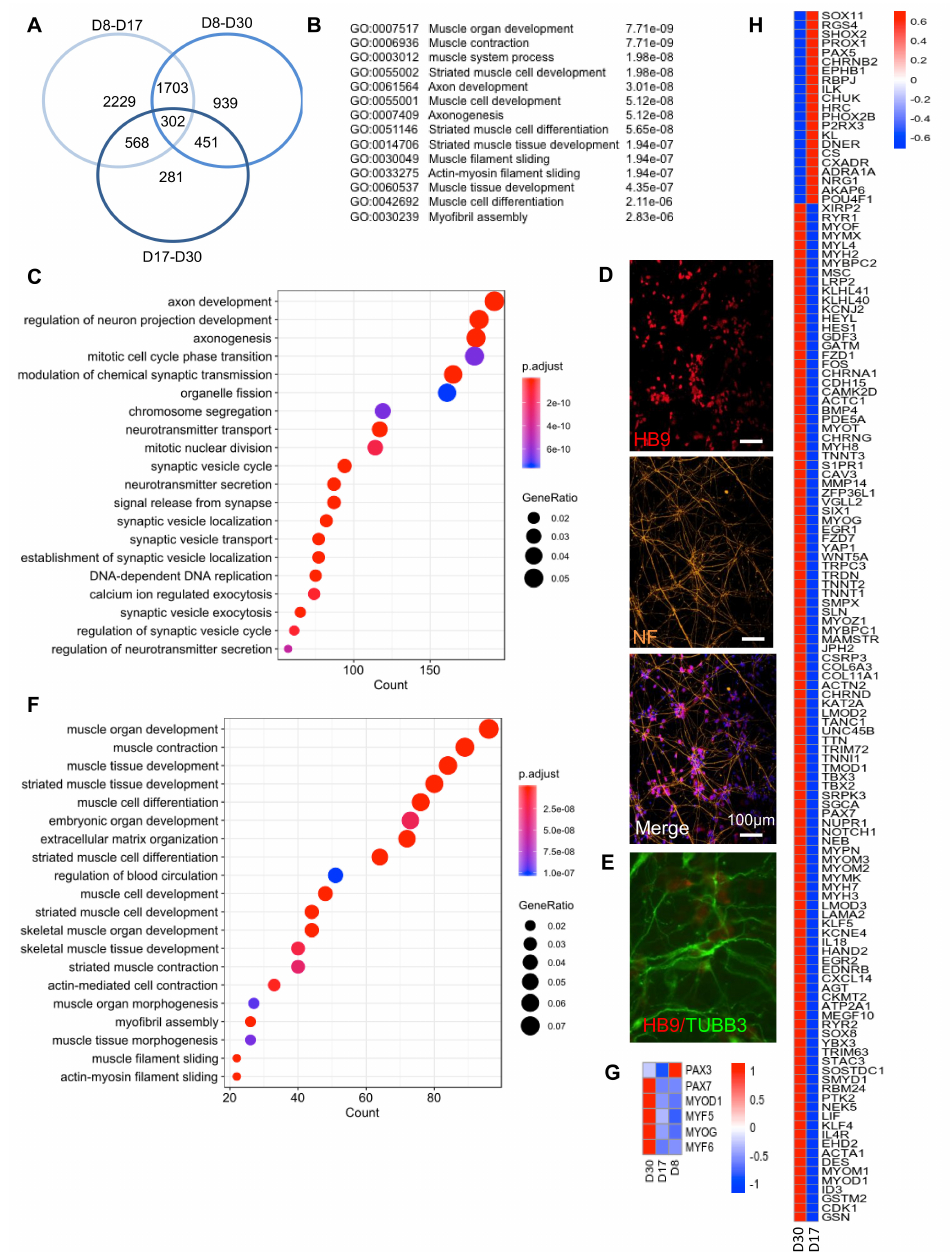
Figure 3. Transcriptomic profiling of in vitro di ff erentiated innervated muscle fibers at day 8, 17 and 30 postdi ff erentiation. ( A ) Venn diagram showing the number of genes di ff erentially regulated between D8 and D30, D8 and D17 or D17 and D30. The three time points correspond to the main medium changes. Genes were selected based on a p adj < 0.05. Lists of genes that are di ff erentially expressed between D8–D17, D17–D30 and D8–30 are given in Supplementary Table S1. ( B ) List of the most significant Biological processes (BP) corresponding to the 302 genes common to the three time points with associated GO term and p adj values. ( C ) Biological pathways significantly overrepresented between D8 and D17. ( D ) Representative Z stacks of hiPSC-derived motor neurons using anti HB9 antibodies (upper panel, red), anti-Neurofilament (NF, orange, medium) and merged (bottom) with nuclei counterstained with DAPI. ( E ) Immunostaining of hiPSC-derived motor neurons using anti HB9 antibodies (red) and anti-TUB β 3 (green) with nuclei counterstained with DAPI. ( F ) Biological pathways significantly overrepresented between D17 and D30. ( G ) Heatmap of the di ff erent myogenic transcription factors at D8, D17 and D30. ( H ) Heatmap of di ff erentially expressed genes corresponding to “skeletal muscle di ff erentiation” between D8, D17 and